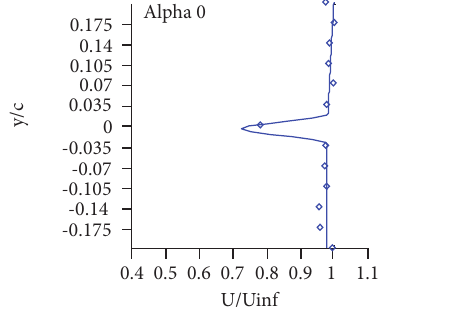
Figure 23. Streamwise velocity profile at x/c = 0.25, Mach = 0.6.